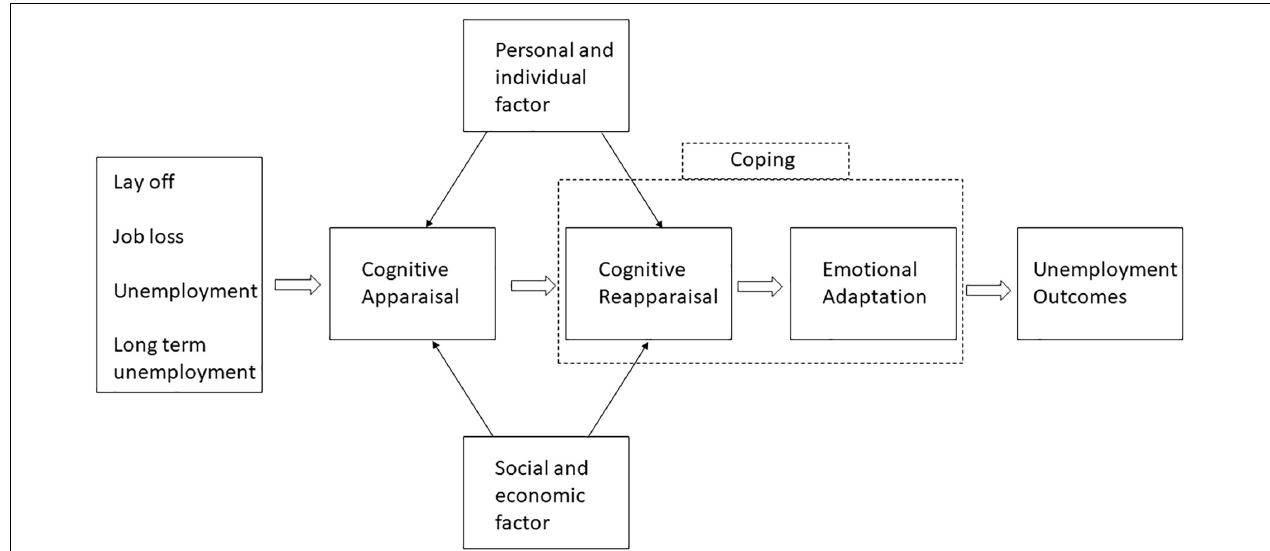
FIGURE 1 | Process of coping with unemployment – a literature summary